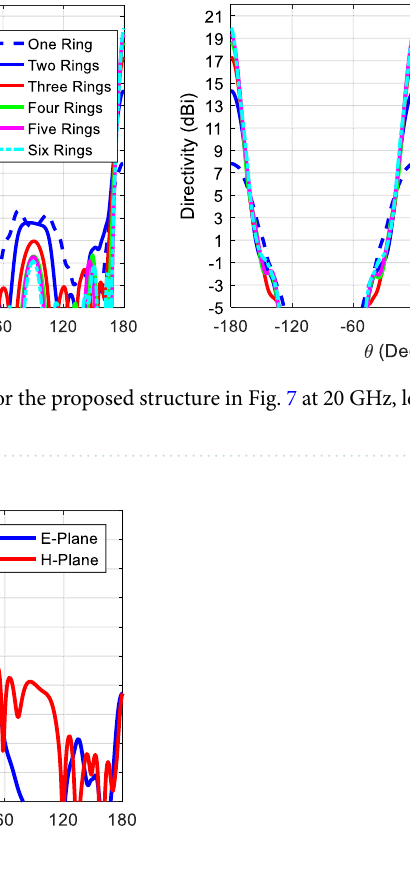
Figure 11. Radiation patterns for the proposed structure (PMC case) at 20 GHz.